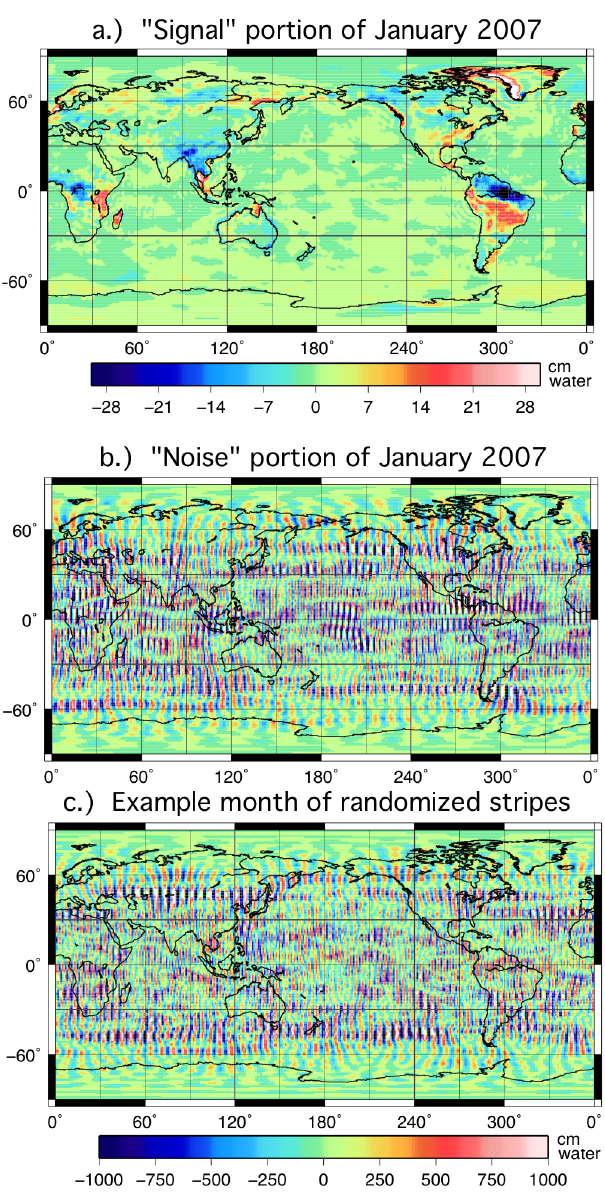
Figure 5. 96 × 96 (a) “model” and (b) “stripe residual” for January 2007, and (c) an example month of simulated 96 × 96